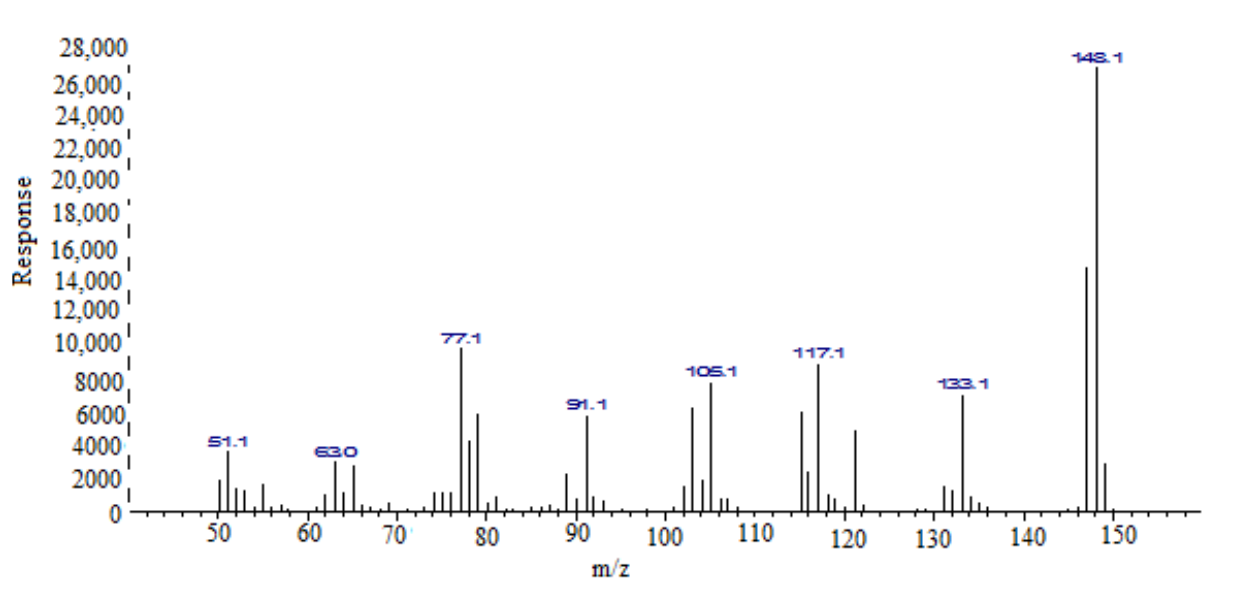
Figure 2. Mass spectra ( m / z ) of standard TOH.